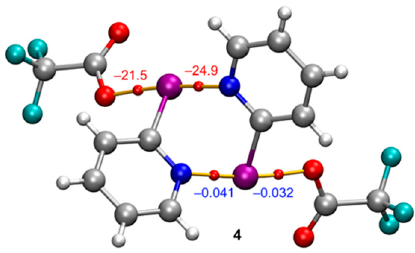
Figure 2. QTAIM analysis of compound 4 . Only intermolecular bond CPs and bond paths are represented. The interaction energies of the ChBs are indicated next to the bond CPs (small red spheres) in kcal/mol. The values of H r (in a.u.) are indicated in blue next to the bond CPs. The C=N bond lengths (1.27–1.30 Å for 5 – 7 ) are typical for C=N double bonds